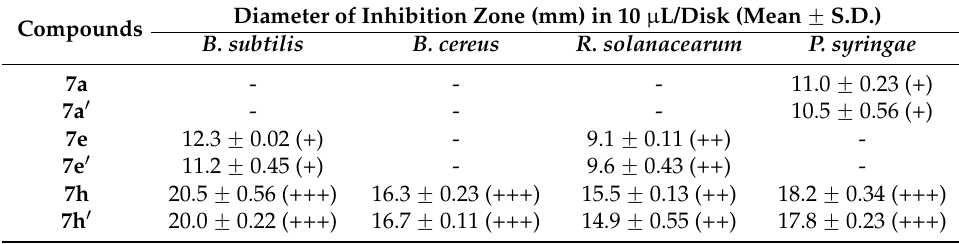
Table 1. Inhibition Zone Diameters of Six Compounds against the Tested Bacteria. Compounds